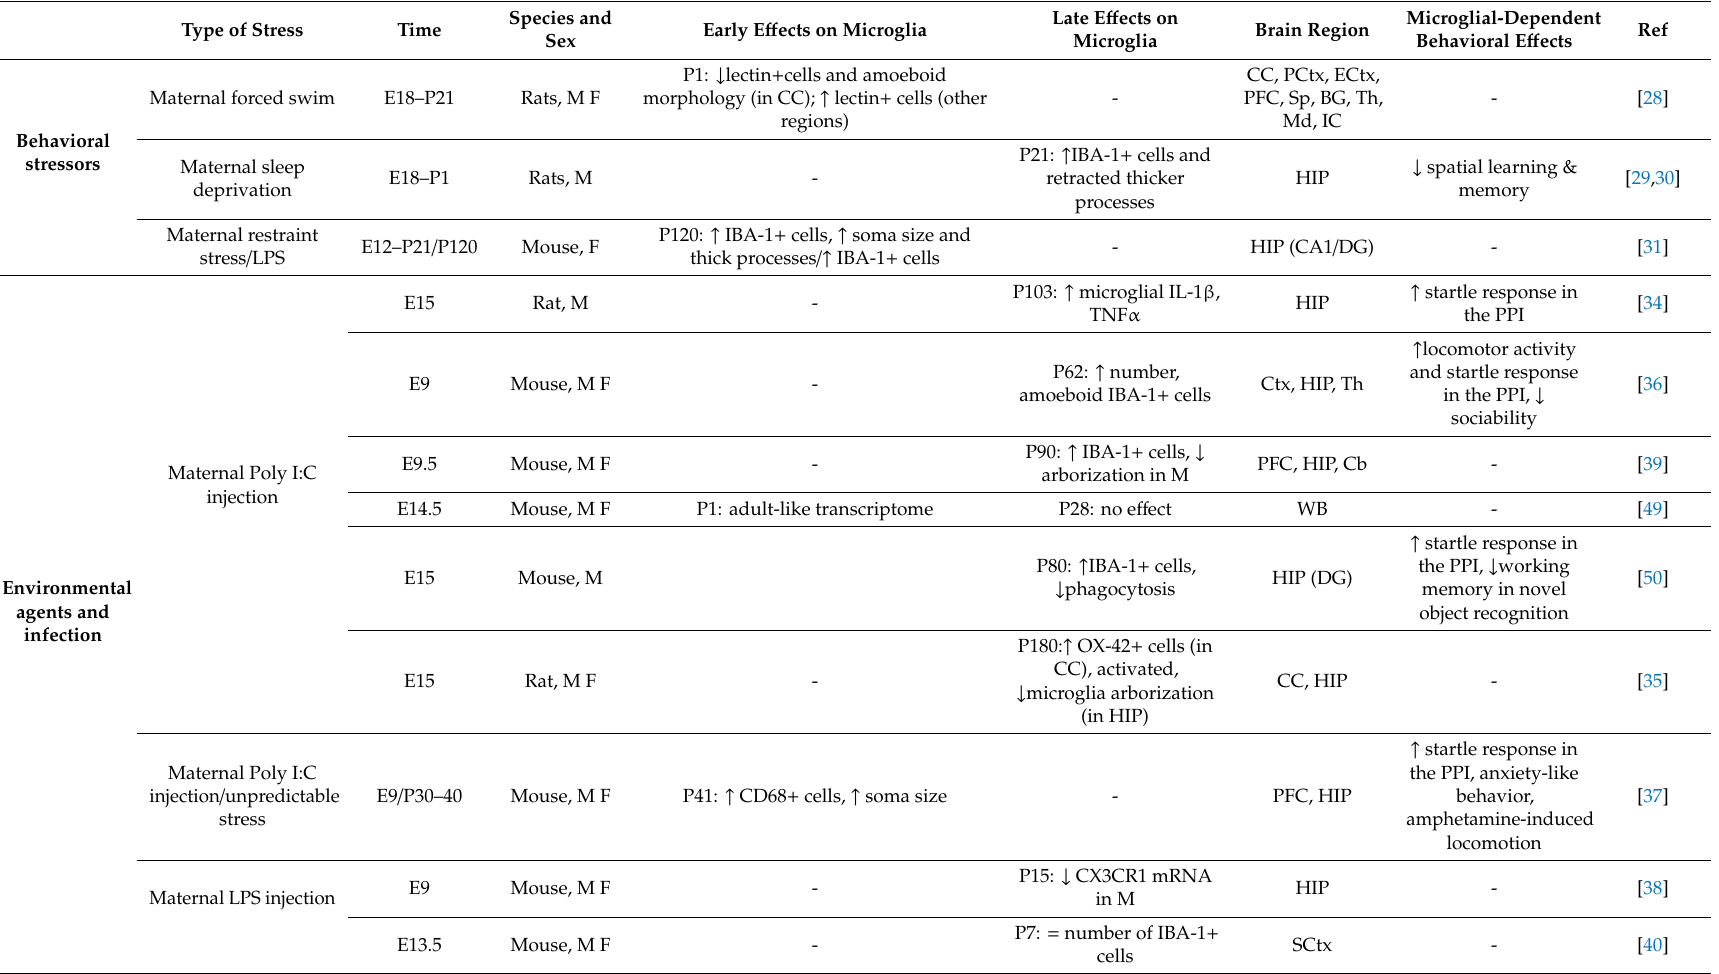
Table 1. E ff ects of prenatal ELS on microglial cell density and phenotype and subsequent behavioral